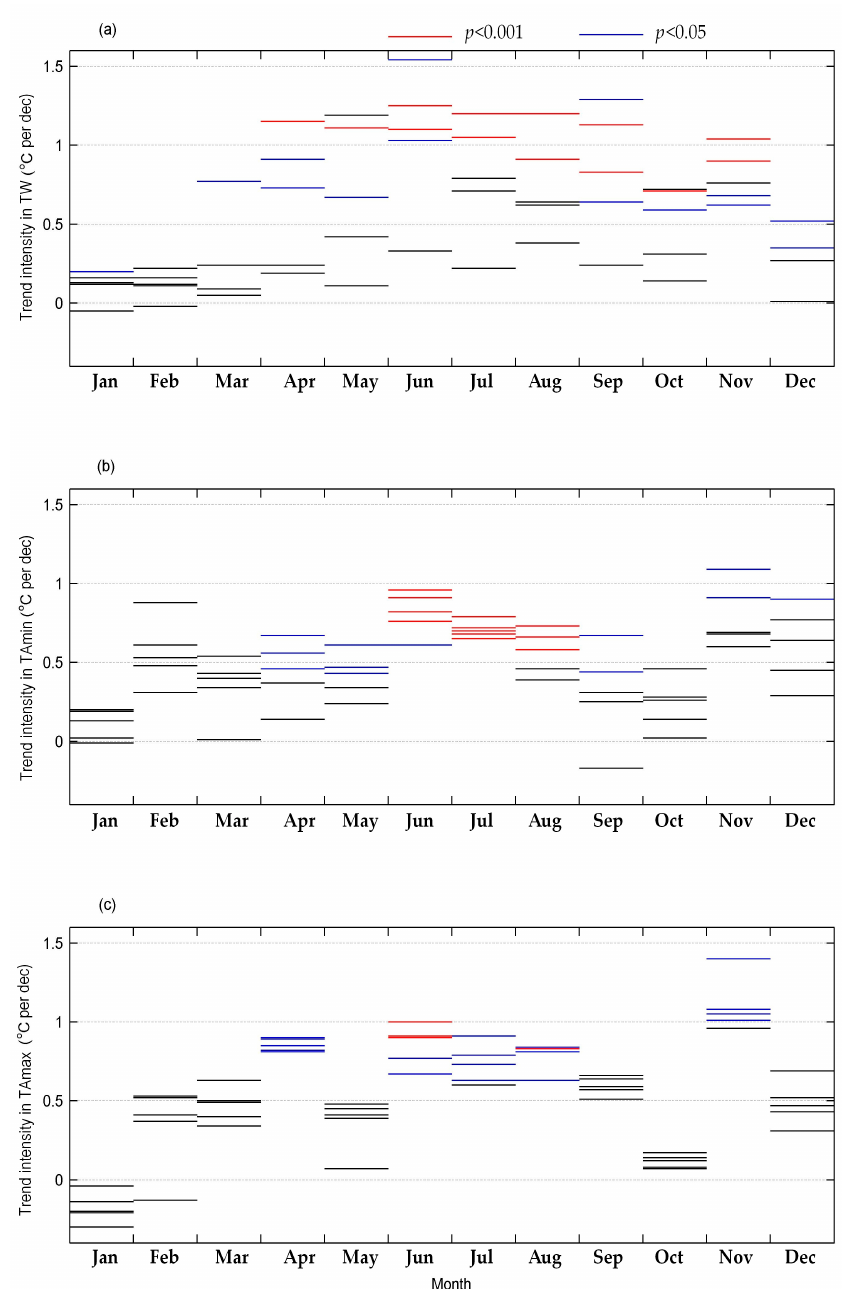
Figure 4. Trend intensity a (°C per decade) for each month for the studied rivers ( a ) in comparison to air temperature trends for TAmin ( b ) and TAmax ( c ) at neighboring stations.